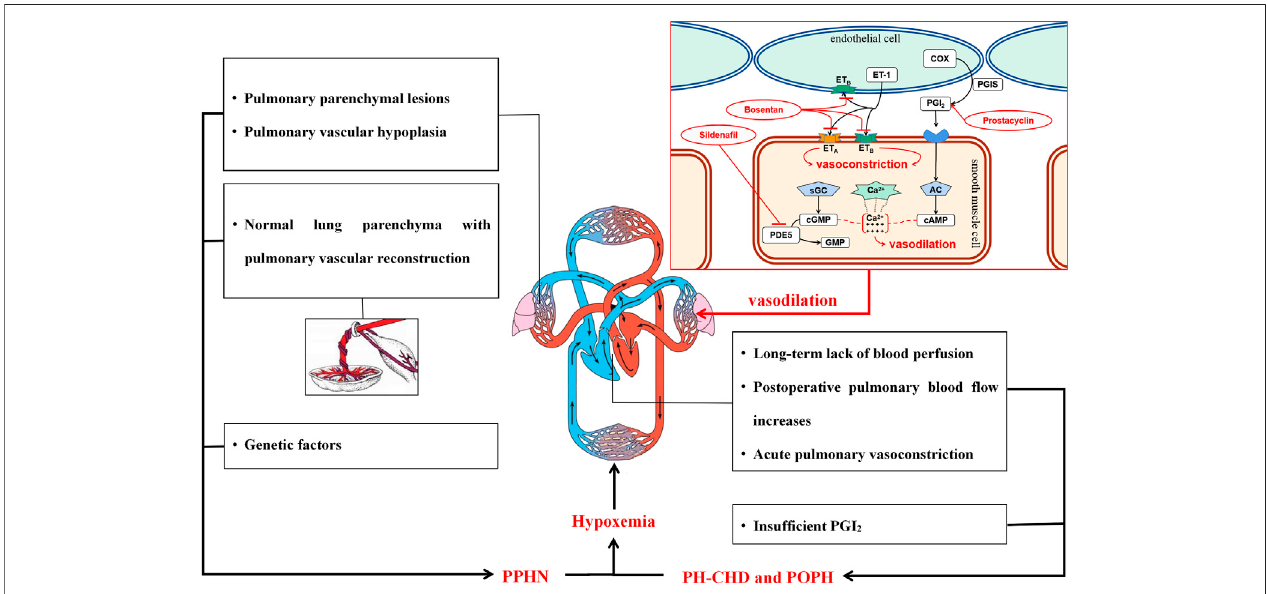
FIGURE 6 | Pathological mechanisms of pediatric PH and pulmonary vasodilators. Abbreviations: PVR, pulmonary vascular resistance; SVR, systemic vascular resistance; ASD, atrial septal defect; VSD, ventricular septal defect; PDA, patent ductus arteriosus; ET-1, endothelin-1; ETA, endothelin receptor A; ETB, endothelin receptor B; PDE5, type 5 phosphodiesterase; COX, cyclooxygenase; PGIS, prostacyclin synthase; PGI2, prostacyclin; sGC, soluble guanylate cyclase; cGMP, cyclic guanosine monophosphate; GMP, guanosine monophosphate; AC, adenylate cyclase; cAMP, 3 ′ -5 ′ cyclic adenosine